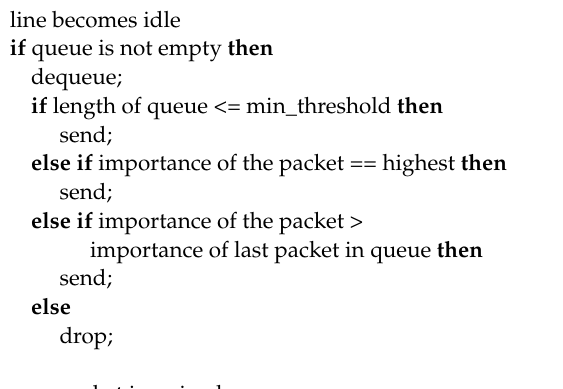
Algorithm 1: Real-time multimedia service class processing